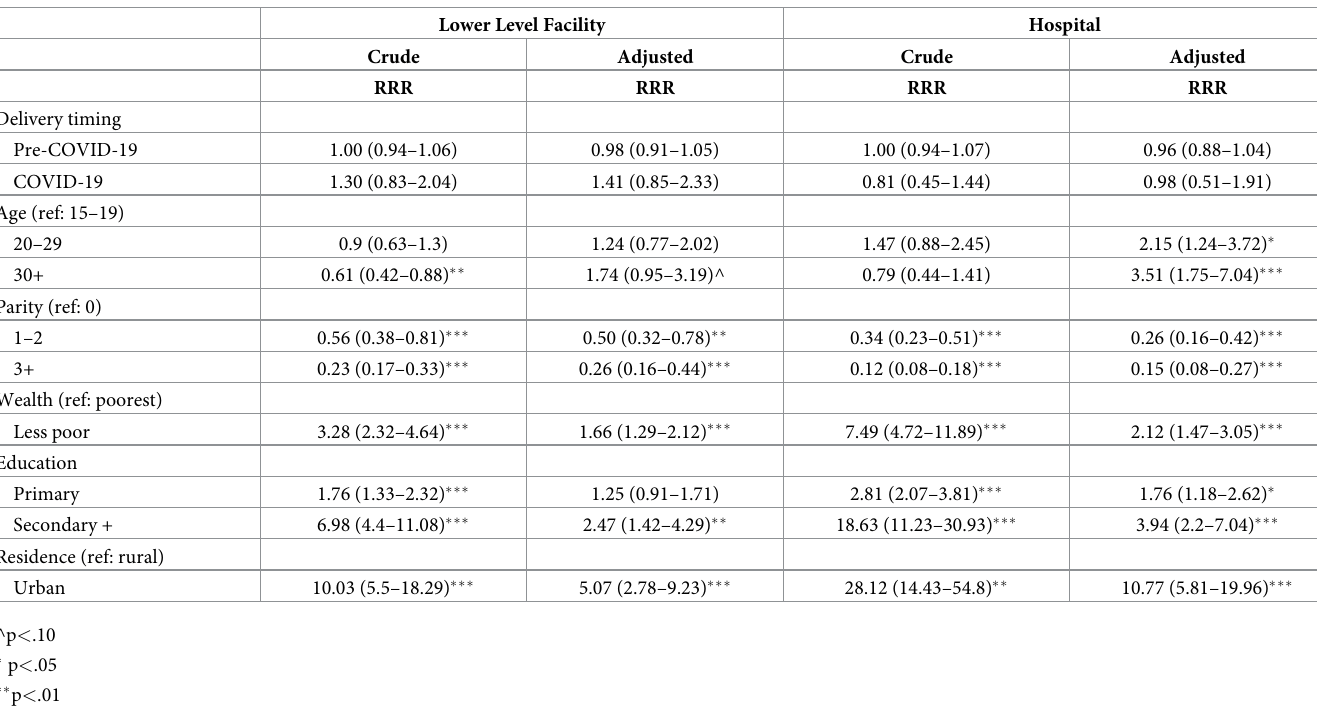
Table 2. Adjusted relative risk ratio of delivering in a lower-level health facility or government hospital relative to home delivery among women